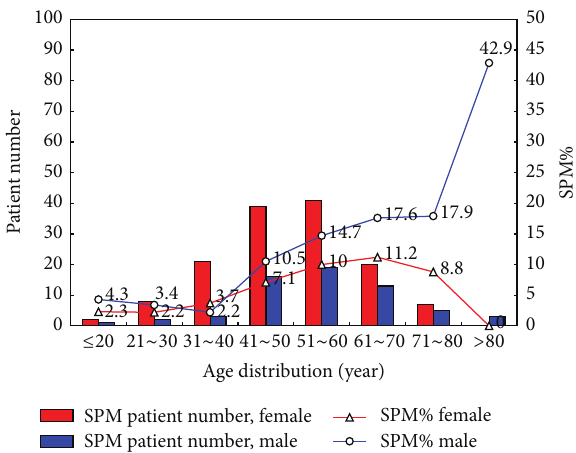
Figure 1: Number and percentage of second primary malignancies by age and sex.